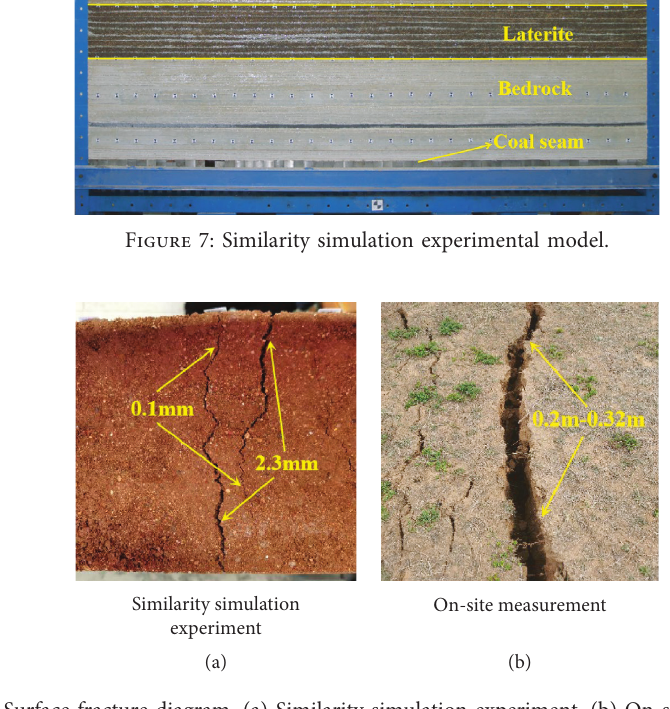
Figure 8: Surface fracture diagram. (a) Similarity simulation experiment. (b) On-site measurement.